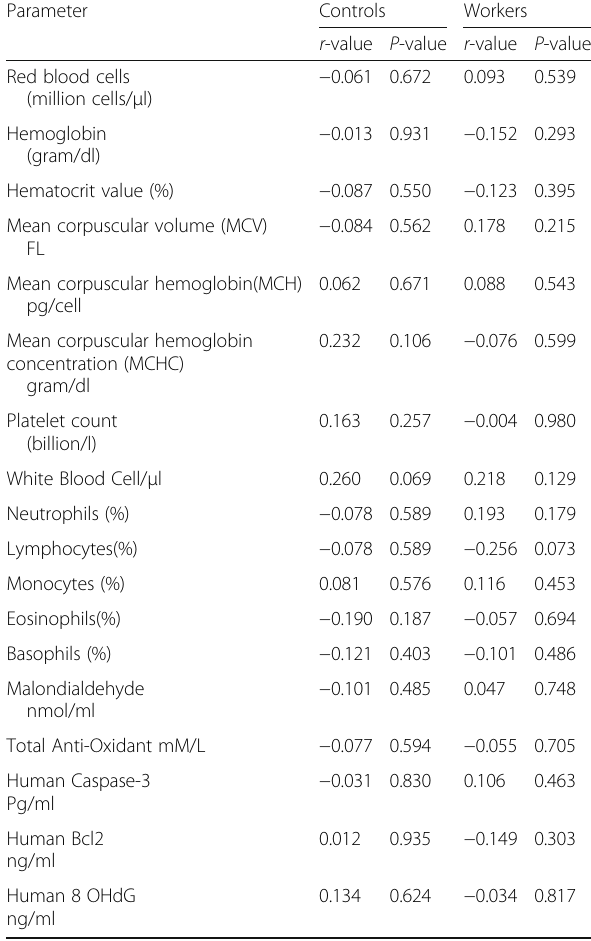
Table 6 Effect of age on the different hematological and biochemical parameters in workers compared to controls Parameter Controls